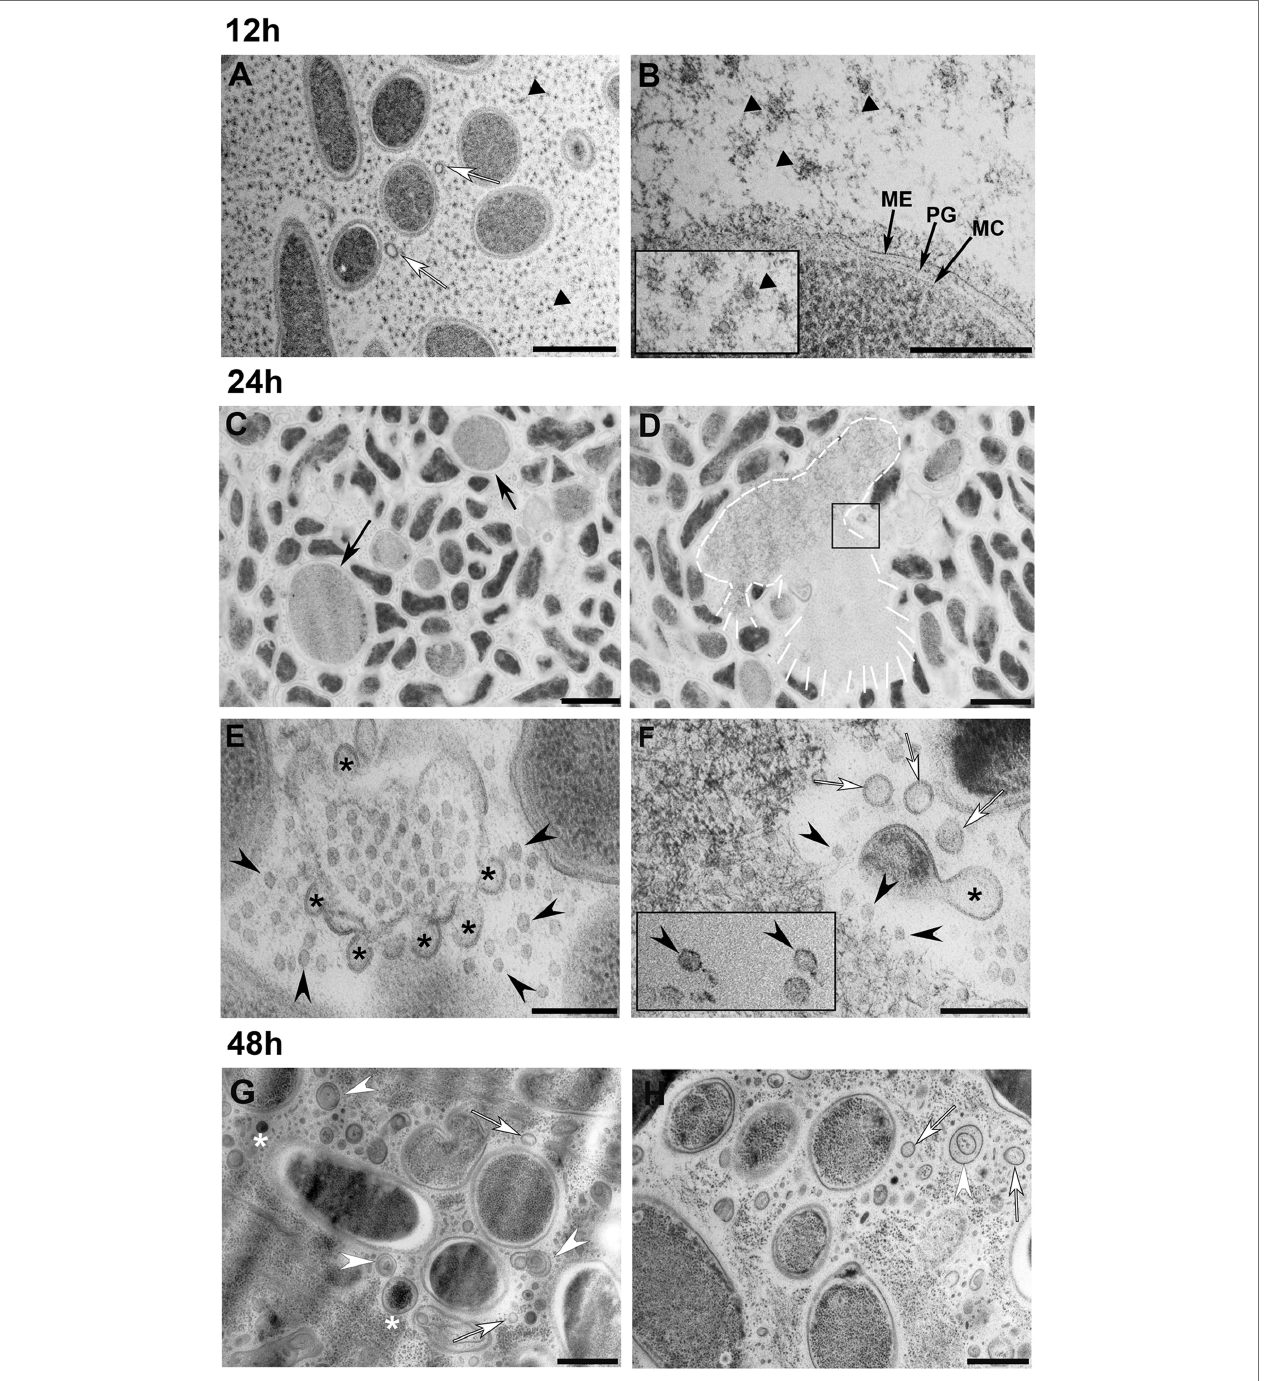
FIGURE 3 | Transmission electron microscopy observation of S. vesiculosa M7 T cells and MVs at different times of growth. S. vesiculosa M7 T cells were collected from TSB liquid cultures by high-speed centrifugation and processed by high-pressure freezing and freeze substitution. The images are representative of the changes produced in cells and extracellular matter during growth of S. vesiculosa M7 T . At 12 h (A,B) , the cells appeared normal, and the extracellular space was occupied mainly by small round structures surrounded by fibrillar material (black triangles in A,B and inset in B ). Some outer membrane vesicles (OMVs) were also observed (white arrows in A ). At 24 h (C–F) , being F an enlarged view of the inset in D , rounded and enlarged cells were visualized (black arrows in C ). Cells exploding were observed (see white line-drawing in D ), and reannealing membranes were detected at these points (asterisks in E–F ) that led to the formation of OMVs (white arrows in F ). At this time point, bacteriophages were observed (black arrowheads in E–F ). At 48 h (G,H) , the extracellular matter was complex containing the elements previously observed such as OMVs (white arrows in G ) and complex vesicles with double-layered membranes (white arrowheads in G,H ) or with electrodense material inside (asterisks in G ). Scale Bars A-C,D , 1 μ m; B-E,F , 200 nm; G,H , 500